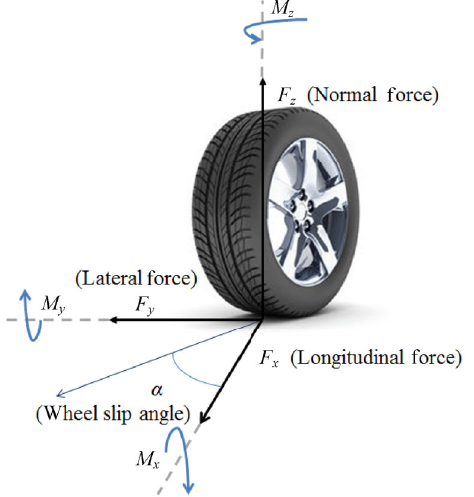
Fig. 1 Free body diagram of a single wheel.